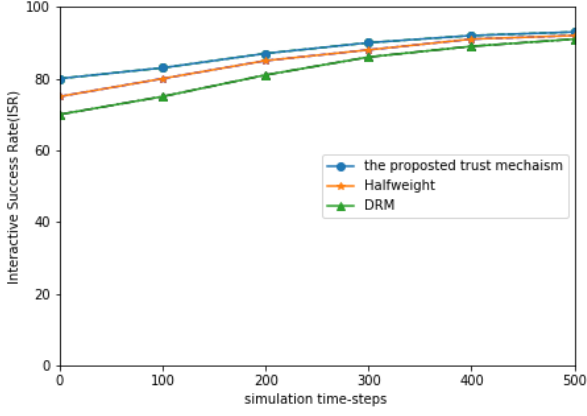
Figure 6. The proportion of MNs is 20% and that of PCN is 20%.